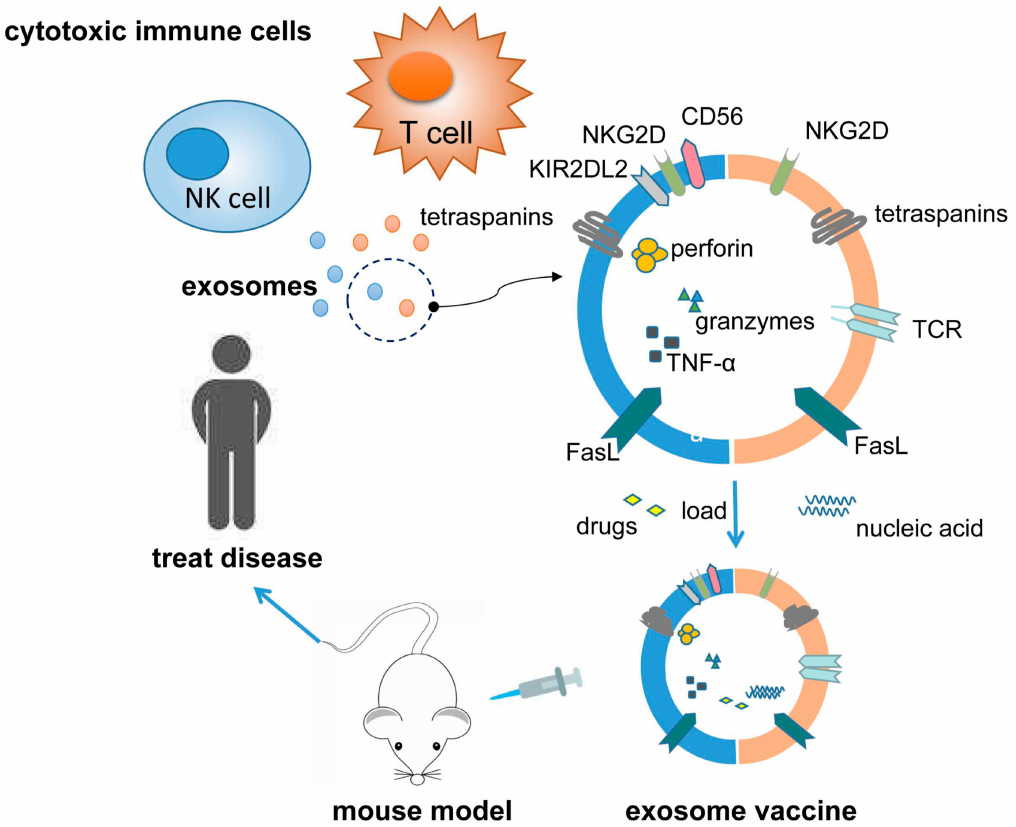
Figure 2. Functions of exosomes derived from cytotoxic immune cells. Exosomes derived from CD8 + T cells and natural killer (NK) cells express recognition receptors for antigens, MHC, or damage signals on target cells and contain cytotoxic mediators, such as perforin, granzymes, and TNF- α that can eliminate tumors or virus-infected targets. These exosomes can also be used as drug delivery systems or vaccines in cancer